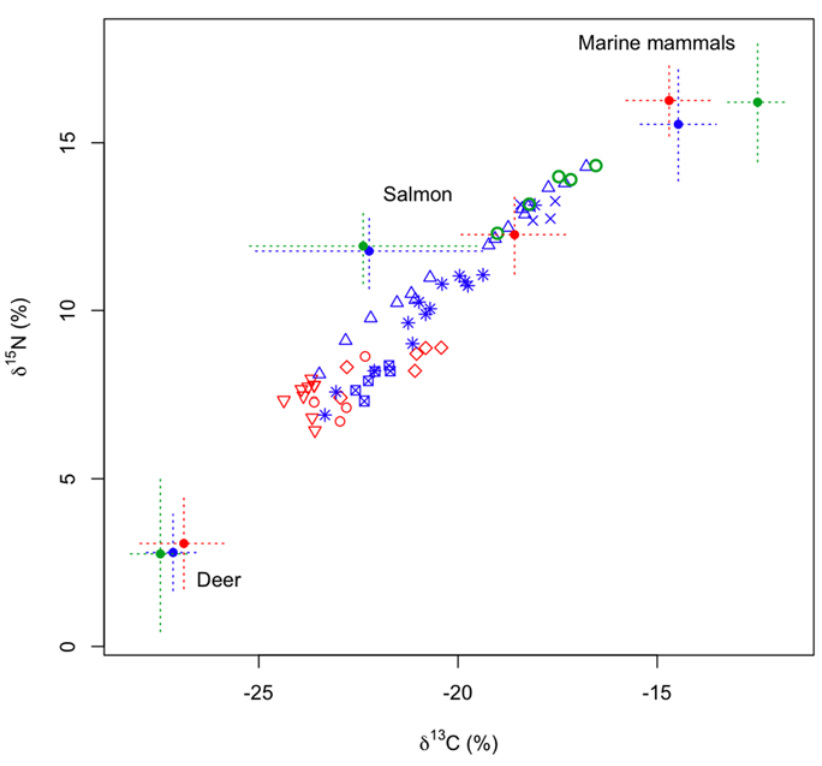
Figure 1. Stable isotope inputs to the hierarchical mixing model for B.C. wolves. Data derived from three regions (mainland, inner islands adjacent to the coast, outer islands). Prey items from each region have unique means (solid dots) and standard deviations (dashed lines) in each isotope dimension. For wolves (n=64), symbols are used to depict group (pack) membership.